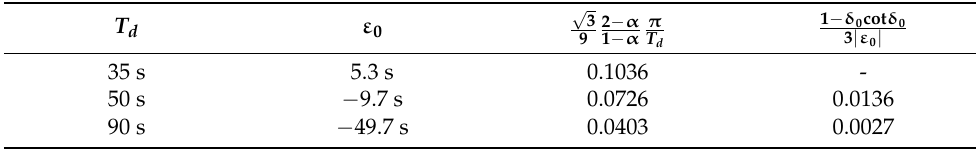
Table 3. Some useful